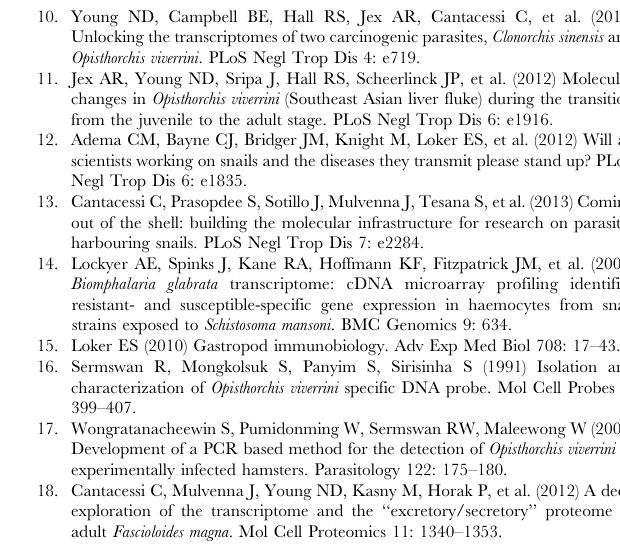
Table S1 The annotated transcriptome of Bithynia siamensis goniomphalos and corresponding sequence data. Summary of annotation data linked to individual assembled transcripts.